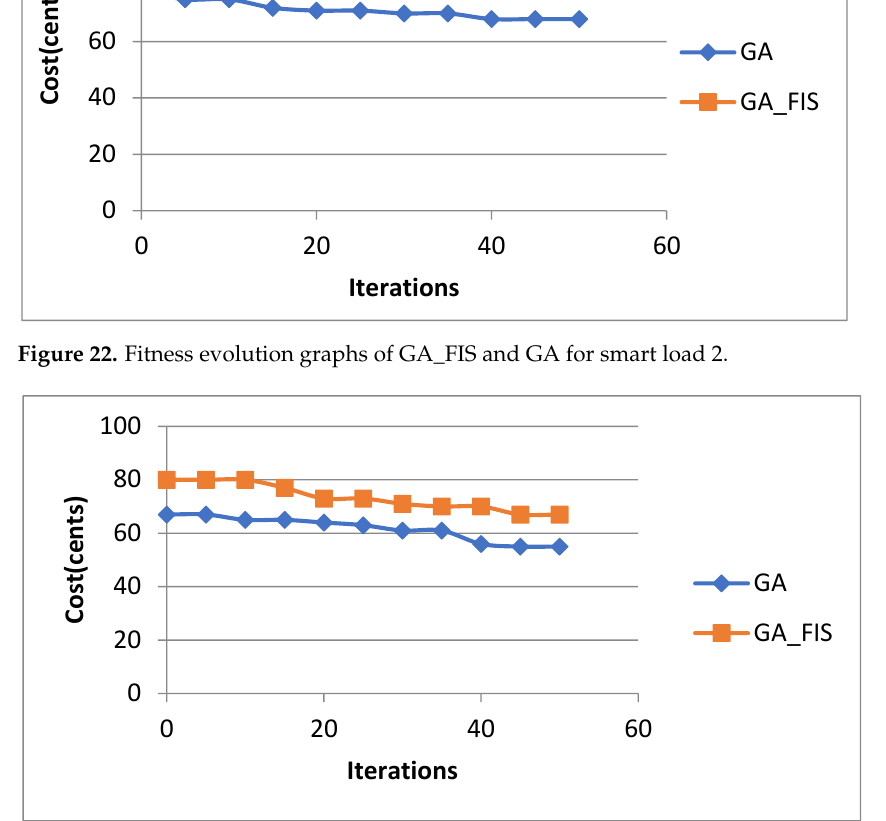
Figure 23. Fitness evolution graphs of GA_FIS and GA for smart load 3.